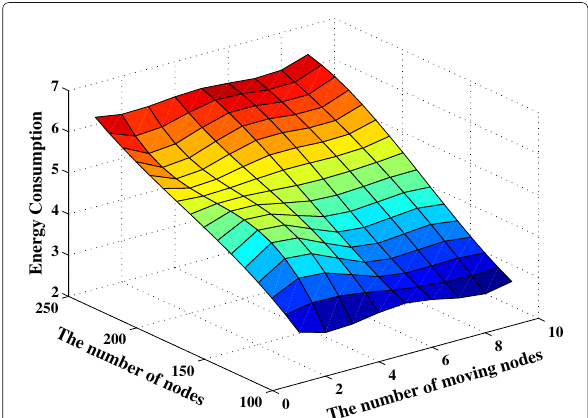
Fig. 9 The relation between energy consumption and the number of nodes, the number of moving nodes